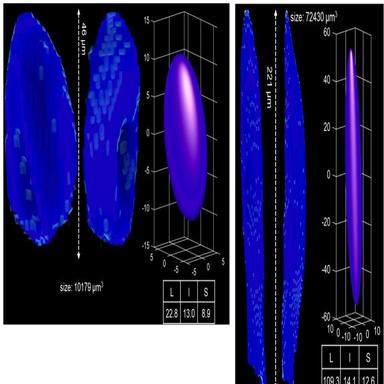
3D visualisations of representative single void and fitted ellipsoid for Victrex Feedstock (top) and L&V Feedstock (right); scale bar shows filament pulling direction (Z axis); L, I, S, axis length expressed in µm.